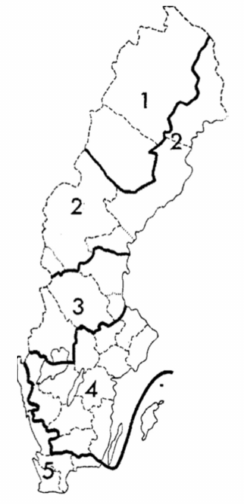
Figure 1. Regional delineation of Sweden in the National Forest Inventory. Regions 1–3 span the southern boreal to northern boreal zone; region 4 belongs to the hemiboreal zone. Region 5 (temperate zone) is not included in the present study.